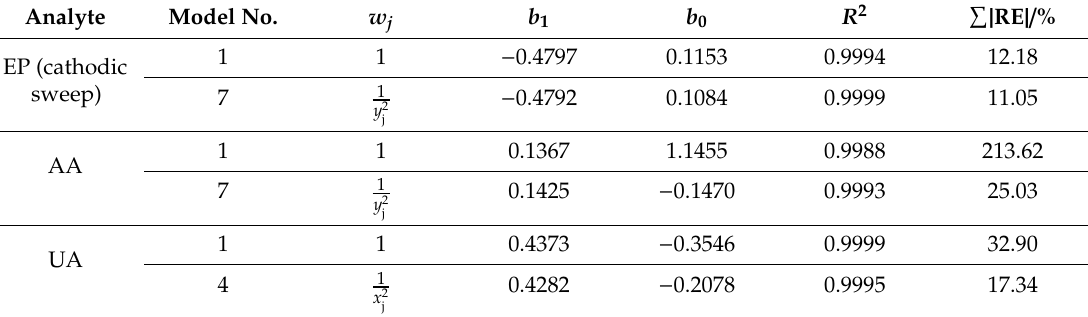
Table 4. A comparison of the unweighted (Model 1, w j = 1) and best weighted regression models with the corresponding regression parameters and the sum of the absolute RE values ( EP (cathodic sweep), AA, and UA